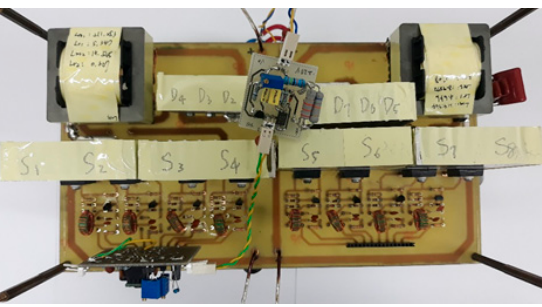
Figure 6. Picture of the proposed converter.